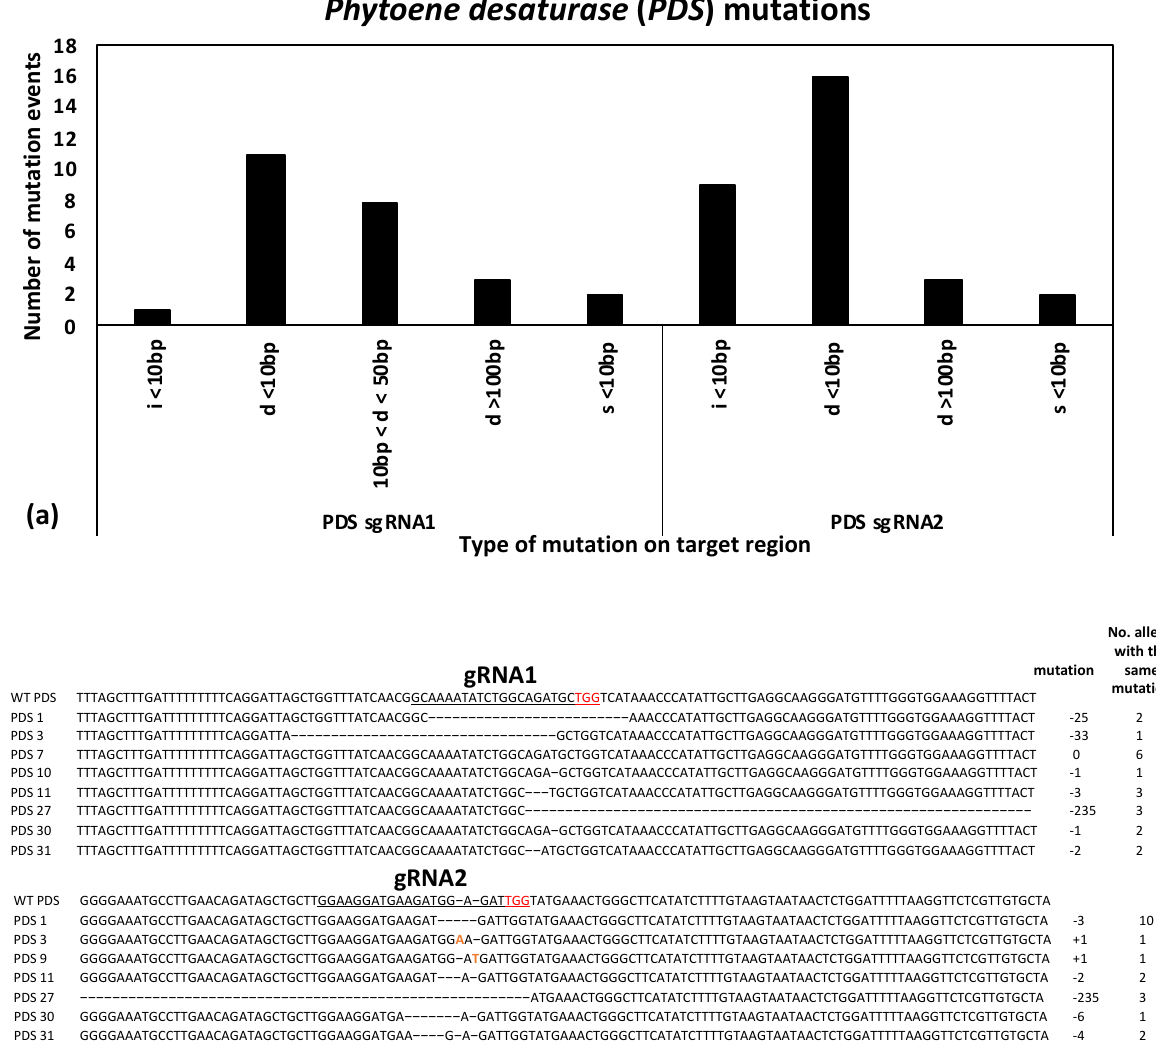
Figure 3. ( a ) Histogram showing the number of different mutation events, including insertions (i), deletions (d), and base substitutions (s), across all edited plants at the PDS target site for the two gRNAs; and ( b ) multiple sequence alignments showing mutations detected at the PDS target site for gRNA1 and gRNA2, which are 204 base pairs apart. The wild type (WT) PDS sequence is shown at top with the gRNA underlined and the PAM underlined and in red, followed by representative samples with differing mutations. The type of mutation is shown as the number of base pairs inserted (+) or deleted (-), followed by the number of alleles with the same mutation detected across the edited progeny. Three alleles were detected with a 235 bp deletion event spanning the PDS gRNA1 and gRNA2. The red bases in gRNA2 represent single base insertions.